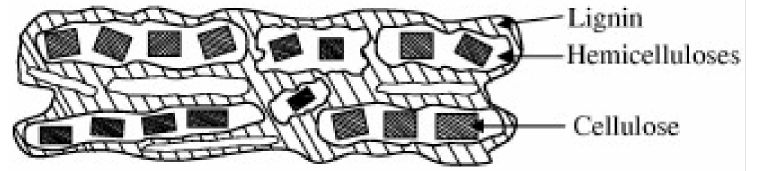
Figure 7. Structural arrangement of the three components of a natural fiber cell wall. Reprinted with permission from Elsevier [53].